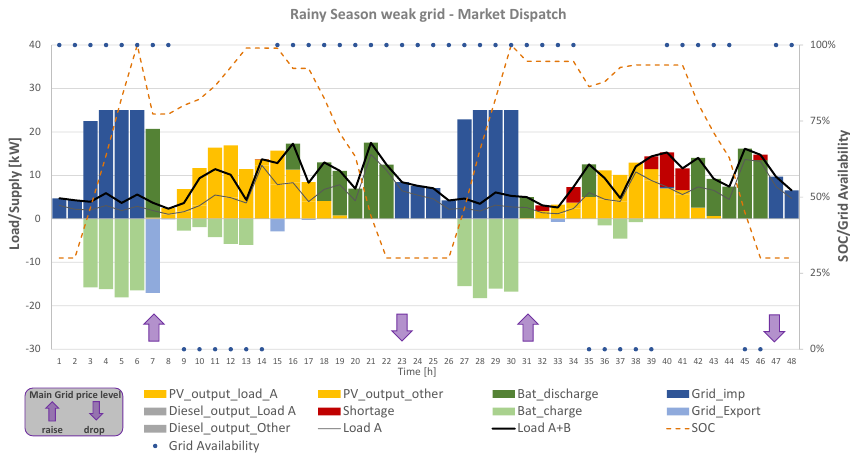
Figure 16. Market–based optimal dispatch for rainy season unreliable grid.